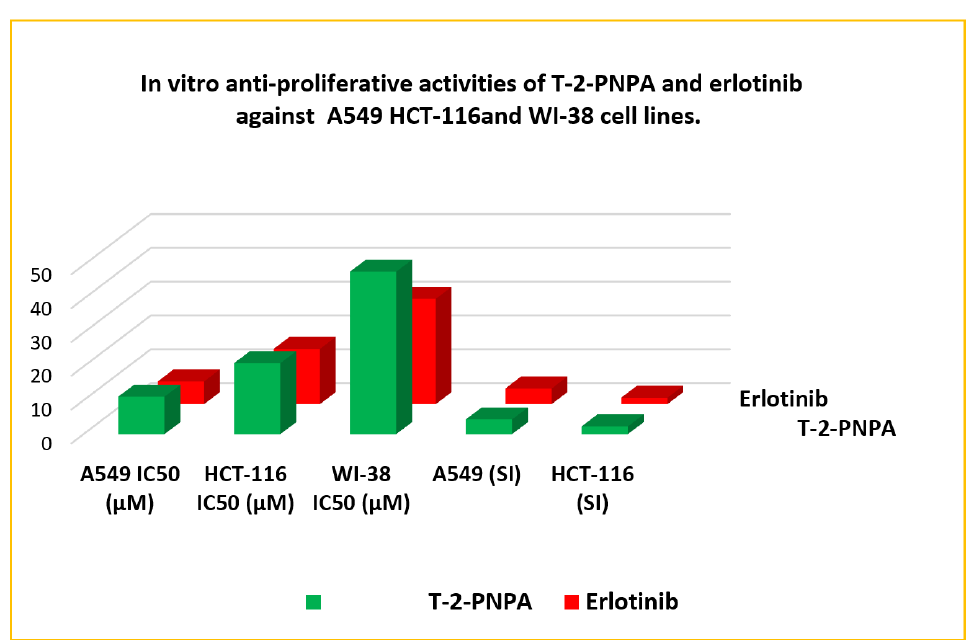
Figure 17. In vitro anti-proliferative and safety assessment of T-2-PNPA against A549, HCT-116, and WI-38 cell lines.